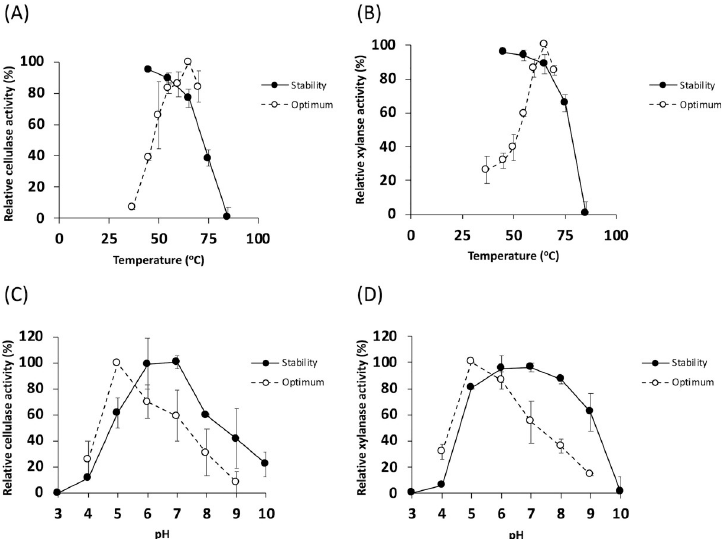
Fig 4. Effect of pH and temperature on crude enzyme. Effects of temperature (A, B) and pH (C, D) on the activity and stability of the crude enzymes from Thermoanaerobacterium s p. R63 were evaluated. Enzymatic activities were investigated by measuring reducing sugar product using DNS method. Relative activity represents specific activity in a given condition compared to the optimum condition. Data were evaluated from three independent experiments. Error bars in graphs represent standard deviation of